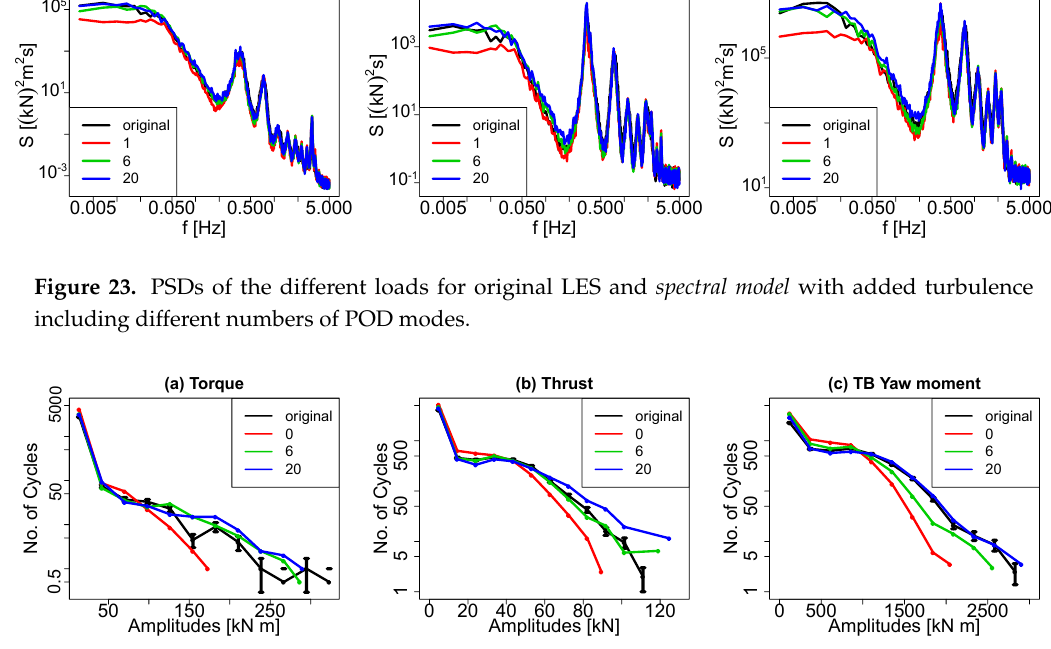
Figure 24. RFCs for different loads and different numbers of modes included in the spectral model with added turbulence.